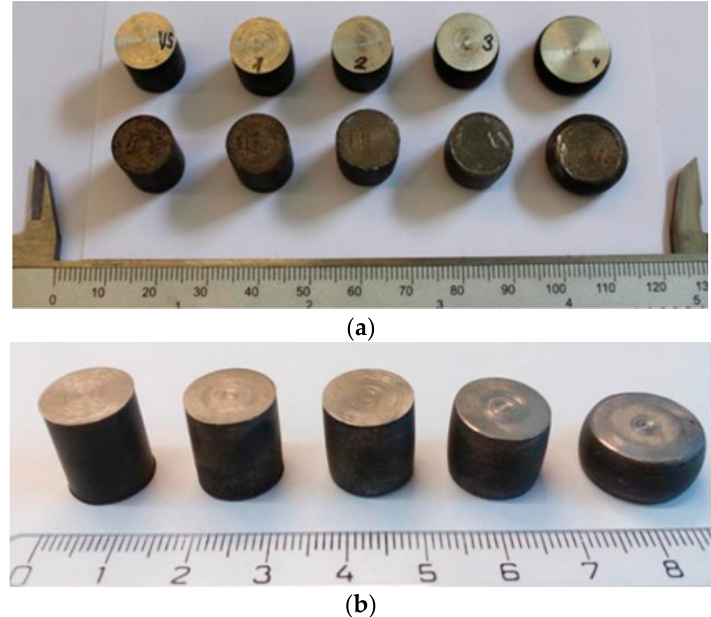
Figure 6. Investigated specimens of AISI 316L austenitic steel ( a ) with a mechanically-treated surface and ( b ) without additional mechanical surface treatment, all stages of plastic deformation.